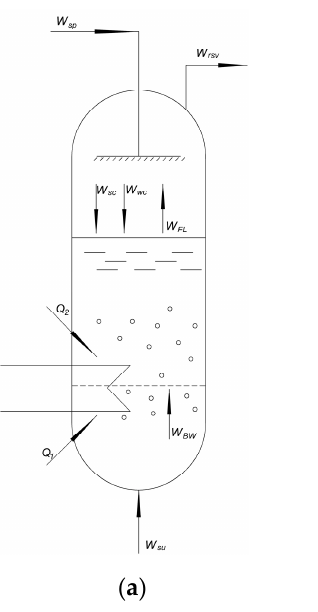
Figure 5. Internal schematic diagram and simplified diagram of pressurizer. (a) The energy and mass transfer inside the pressurizer; (b) Simplified diagram of pressurizer principle.